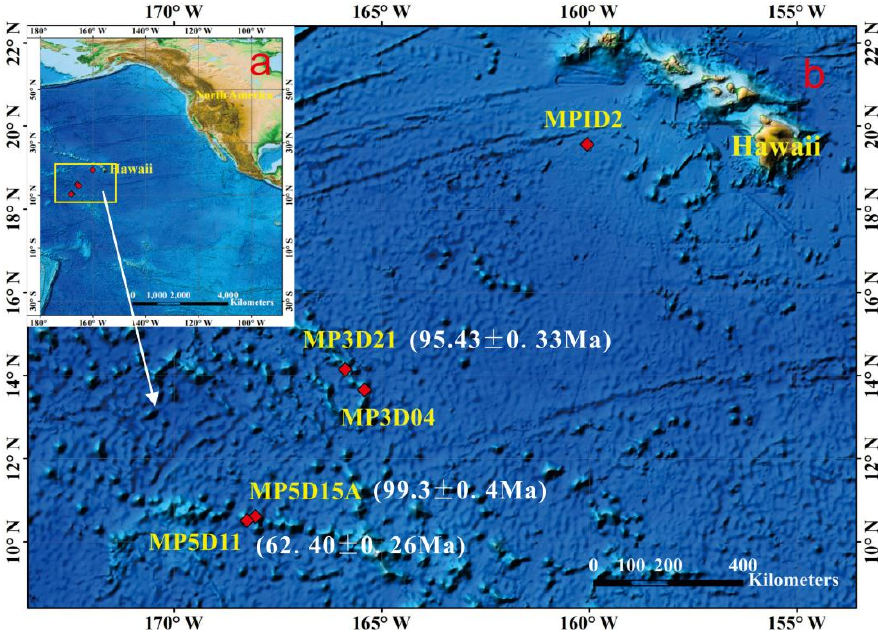
Figure 1. Bathymetric map of the study area in the Western Pacific ( a ) and sampling stations; ( b ) the numbers marked in the figure are the age of seamount basalt.